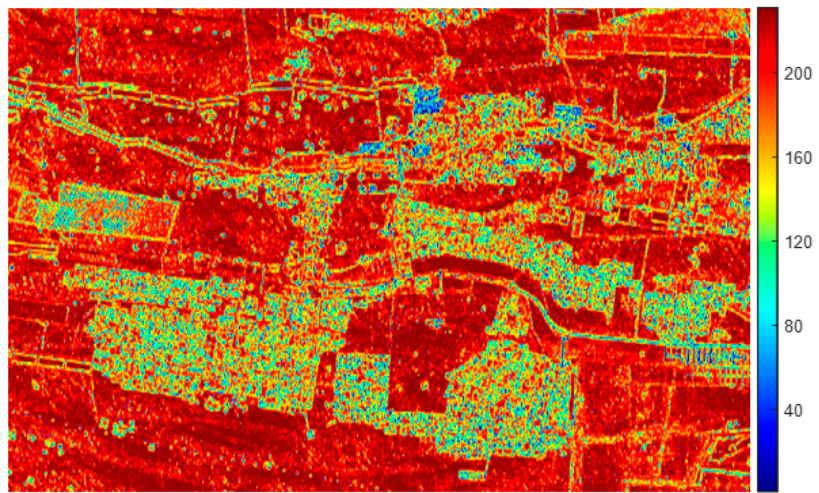
Figure 11. The SHP Figure 11. The SHP numbers .